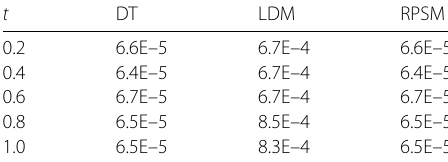
Table 5 Comparison of computing time for u 2